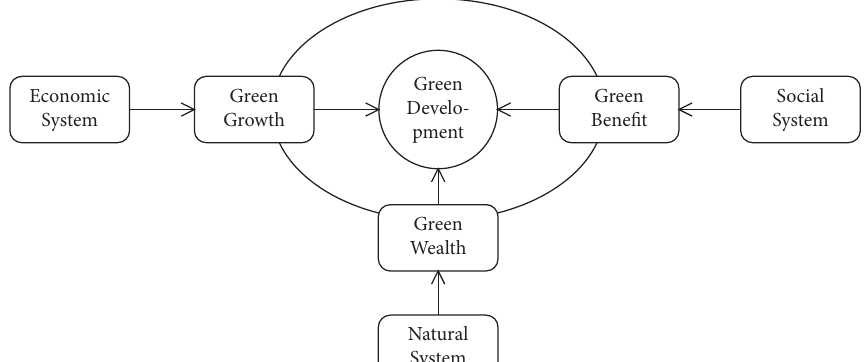
Figure 2: Concept framework of green